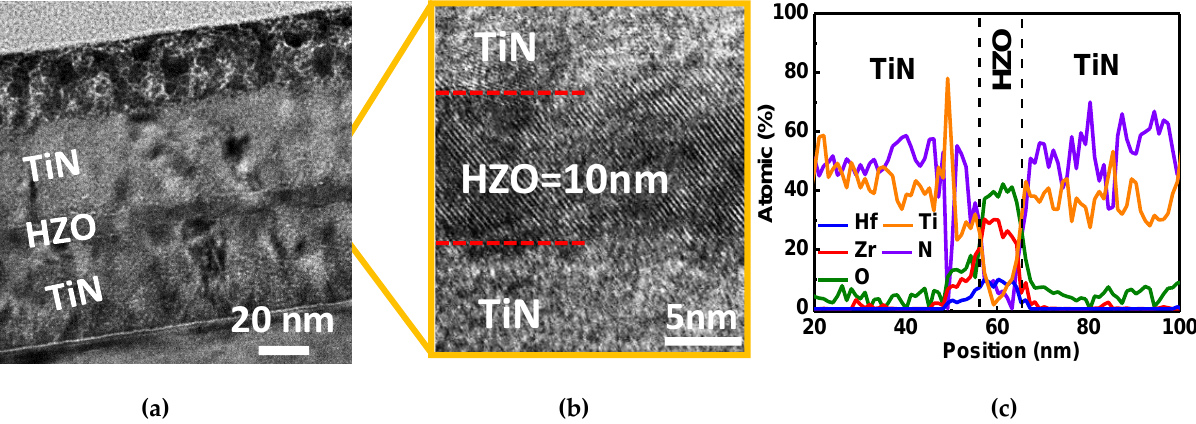
Figure 1. ( a ) Cross-sectional HR-TEM image of the TiN/HZO/TiN stack, ( b ) magnified of stack structure to enlarge and identify the HZO thickness 10 nm and the polycrystalline morphology after annealing. ( c ) EDS of TiN/HZO/TiN. The elements and thicknesses agree with the nominal condition of device fabrication.